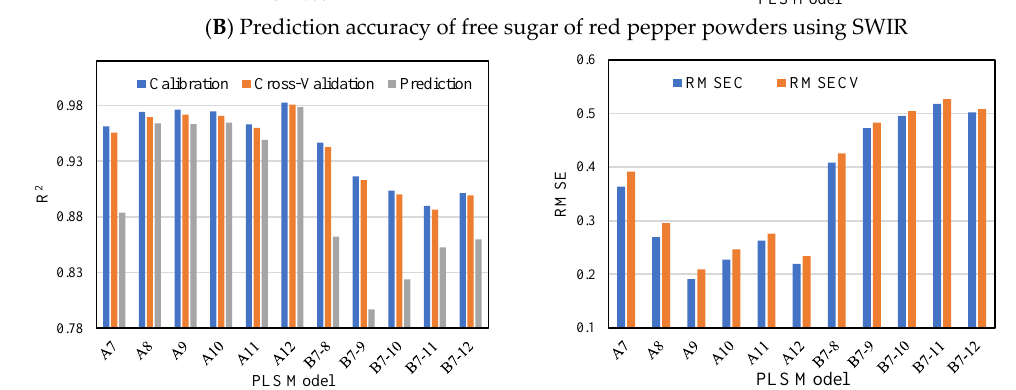
( C ) Prediction accuracy of ASTA color of red pepper powders using SWIR Figure 6. Cont